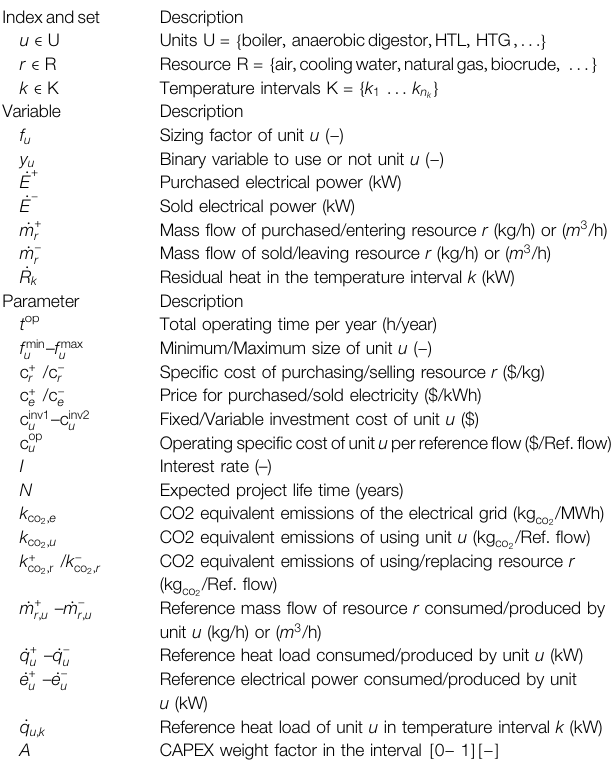
TABLE 6 | Index, sets, variables and parameters in the MILP formulation.